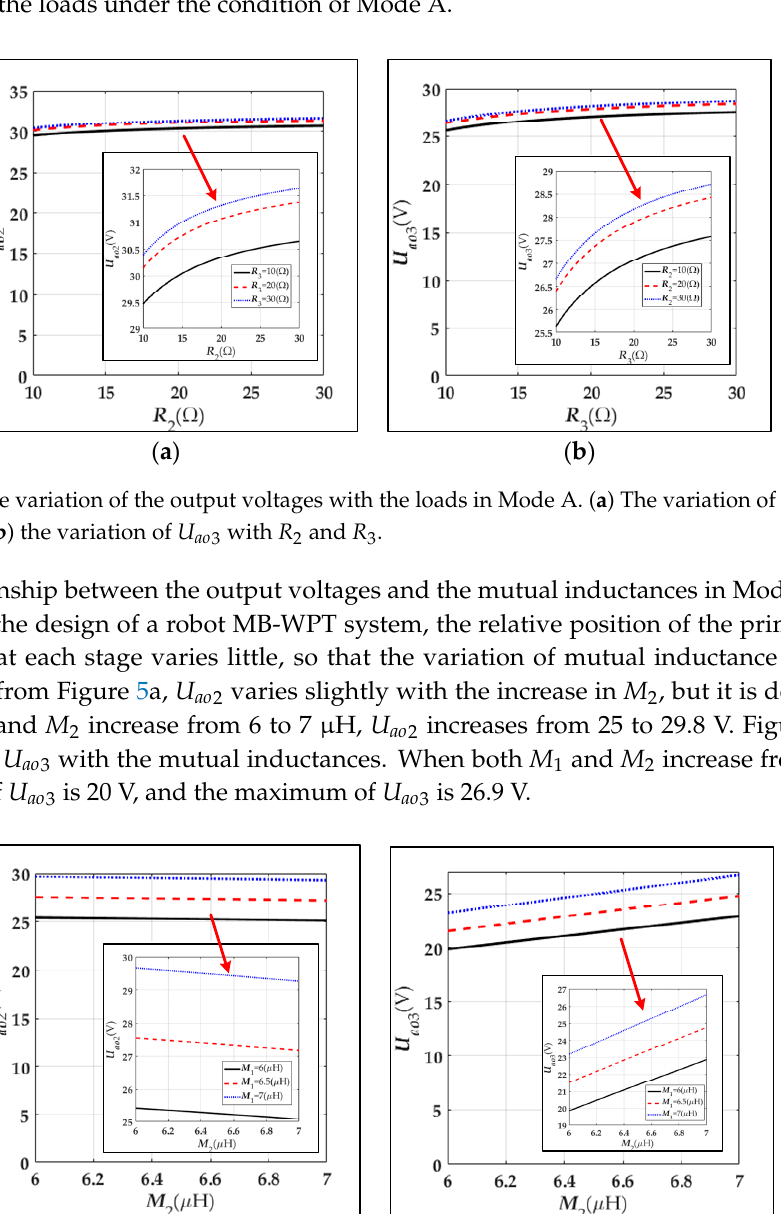
Figure 6. The variation of the output voltage with the mutual inductance and the load in Mode B. 4.2. Analysis of the Efficiency In the WPT system, the efficiency is worthy of attention. The calculated results and analysis of the variation of the efficiency with the mutual inductances and the loads are as follows. The variation of the efficiency η with the mutual inductances and the loads in Mode A are shown in Figure 7. Figure 7a shows the variation of η with the increase in the loads. η increases with the increase in R 2 and R 3 . When the loads R 2 and R 3 increase from 10 to 30 Ω , the efficiency η increases from 87% to 94.5%. Figure 7b shows the variation of η with the increase in the mutual inductances. It can be observed that η varies slightly with the increase in M 1 , but it decreases with the increase in M 2 . When the mutual inductances M 1 and M 2 increase from 6 to 7 μ H, the efficiency η decreases from 83.7% to 82%.